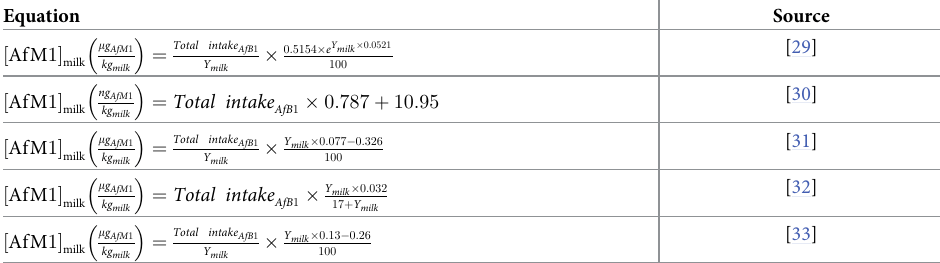
Table 2. Equations used for modelling the transfer of AfB1 in feed to AfM1 in milk. Equation